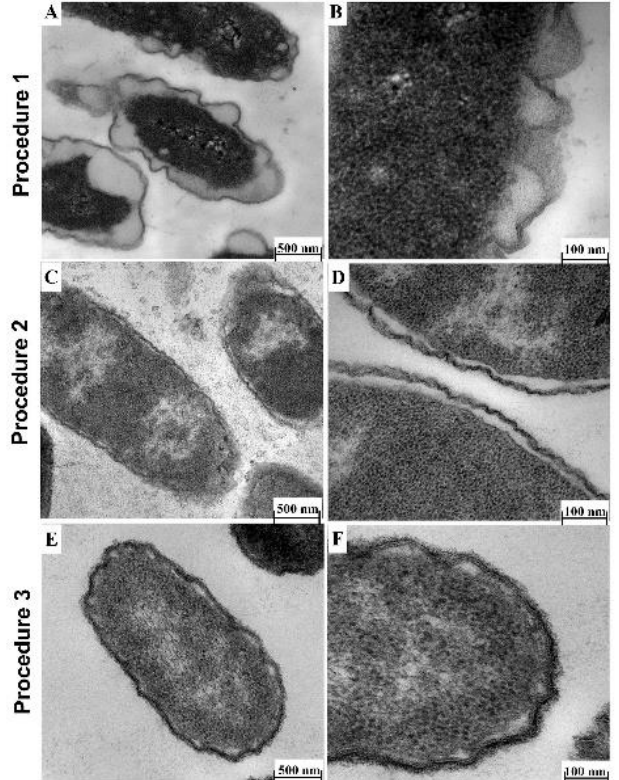
Figure 2. Effect of fixatives and buffer conditions on morphology of Xen14 cells by TEM. ( A , B ) TEM (Procedure 1) using fixatives containing 3.0% formaldehyde, 0.035% glutaraldehyde and 4% sucrose in LR-White resin; ( C , D ) TEM (Procedure 2) using PBS buffer containing 4.0% formaldehyde, 1.25% glutaraldehyde, 4% sucrose and embedded in Epon resin; ( E , F ) TEM (Procedure 3) using cacodylate buffer 4.0% formaldehyde, 1.25% glutaraldehyde and Epon resin embedding without sucrose supplementation.